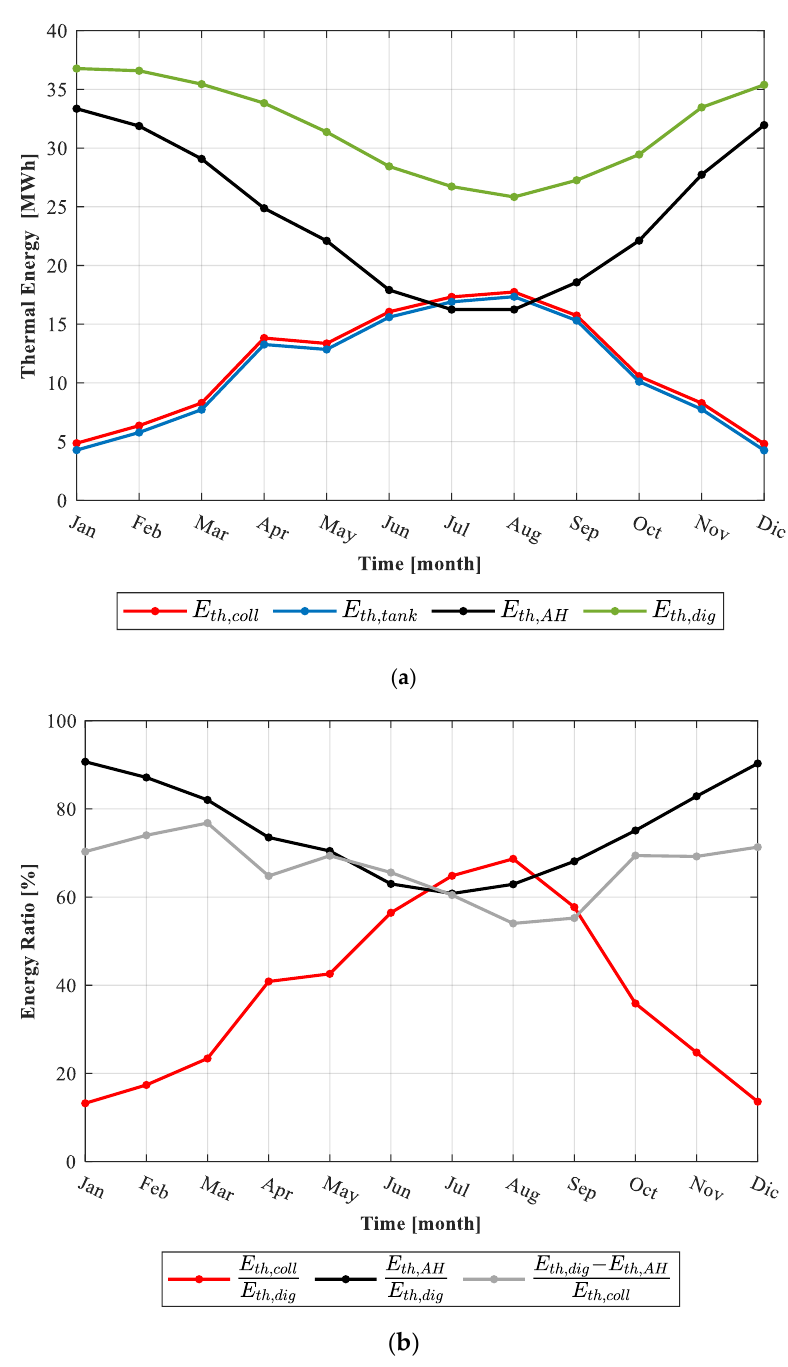
Figure 5. Results for monthly thermal energies. Figure 5. Monthly results for thermal energies ( a ) and thermal energy ratios ( b